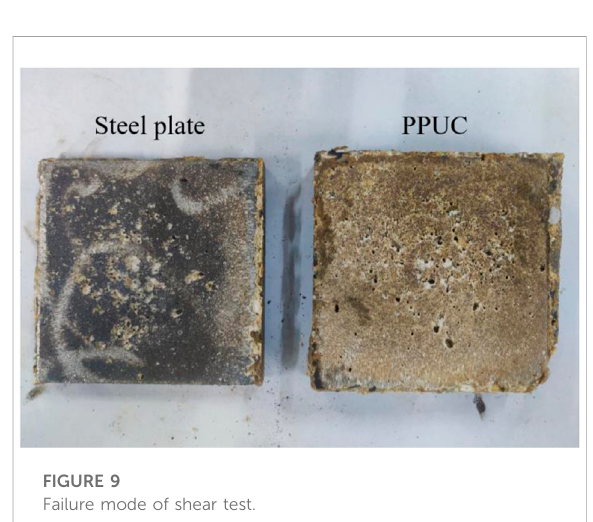
FIGURE 9 Failure mode of shear test.